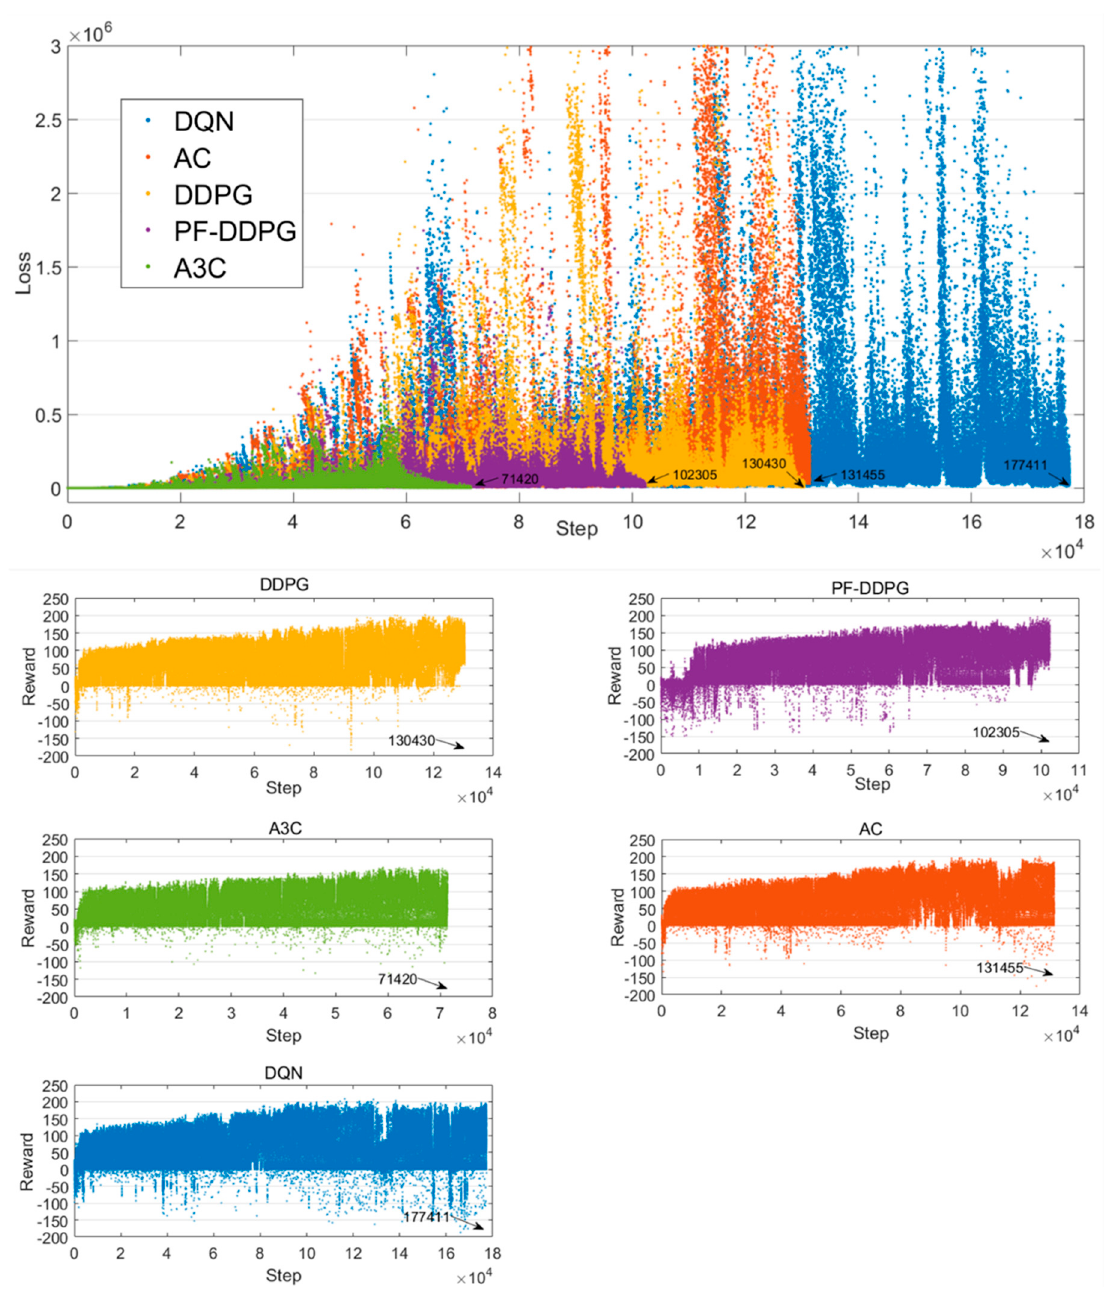
Figure 5. Loss value and reward value of the training process.